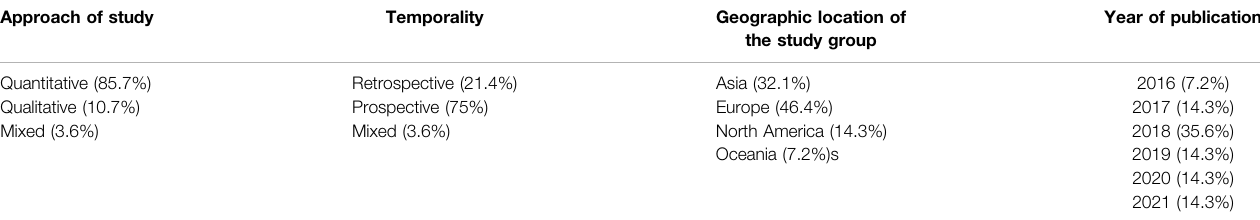
TABLE 1 | Main characteristics of selected